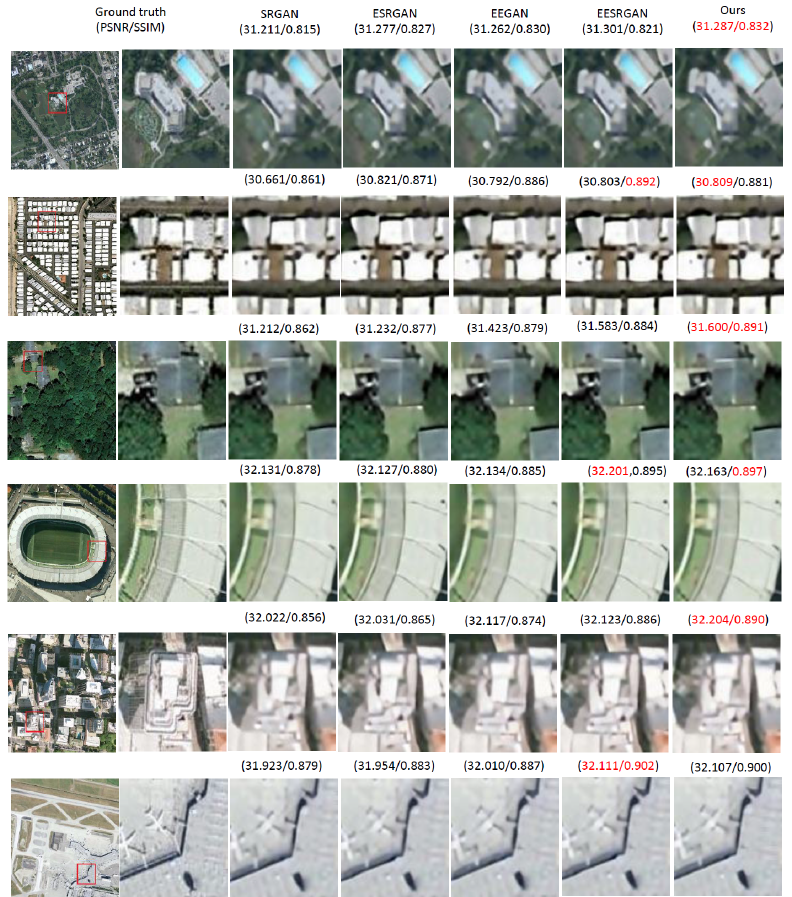
Figure 11. SR visual result comparison for all models in the WHU-RS19 dataset, where the best results are shown in red font.